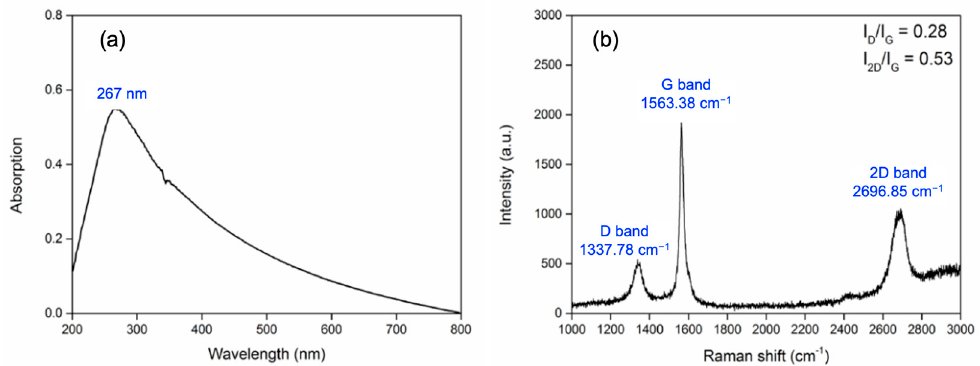
Figure 1. ( a ) UV–VIS spectrum and ( b ) Raman spectrum of GNP powder.